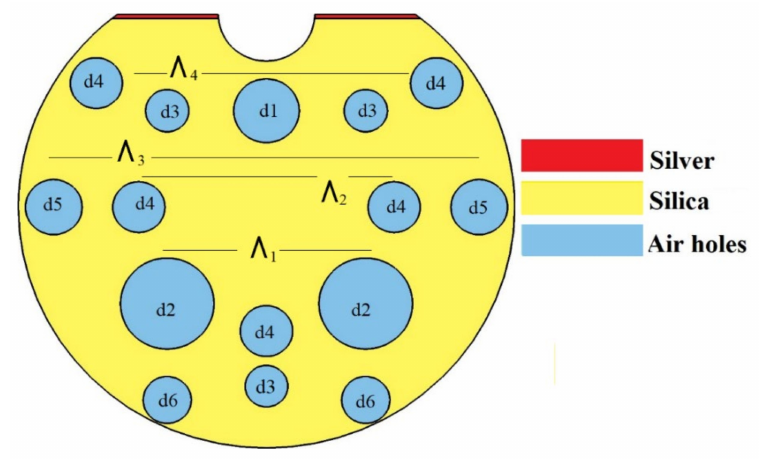
Figure 1. Proposed silver lining D-shaped PCF (for both filter and sensor